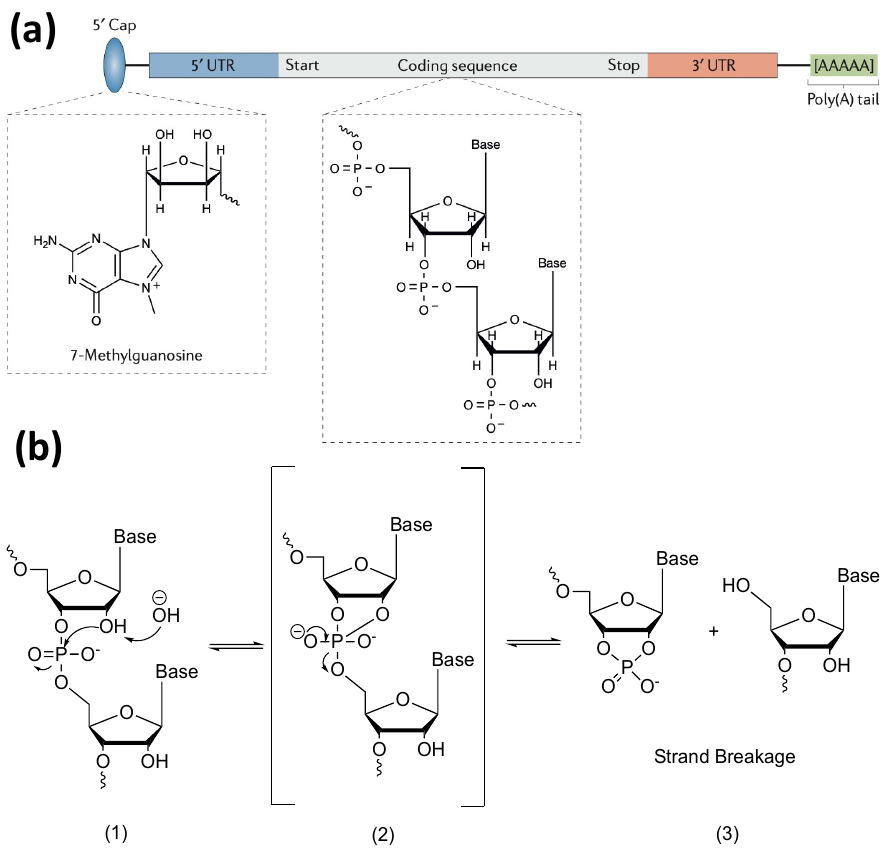
Figure 1. ( a ) Structure of native mRNA. Figure reproduced from Hajji and Whitehead (2017) with permission [44]; ( b ) the mechanism of base-catalyzed mRNA in-line hydrolysis. The base is represented by “OH − ” in the figure. Mechanism reproduced from Pogocki and Schoneich (2000) via Chemdraw with permission [16].